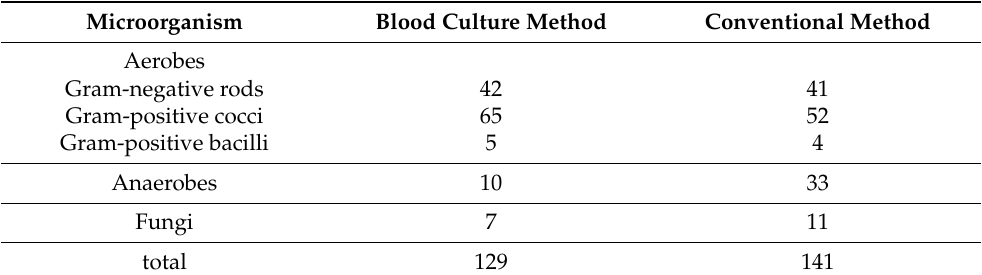
Table 3. Groups of microorganisms isolated by blood culture or conventional culture